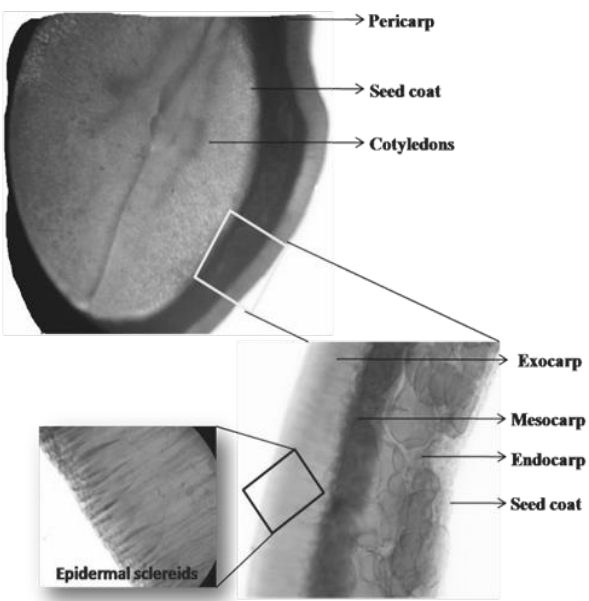
Figure 3 : Transverse section of fruit from H.